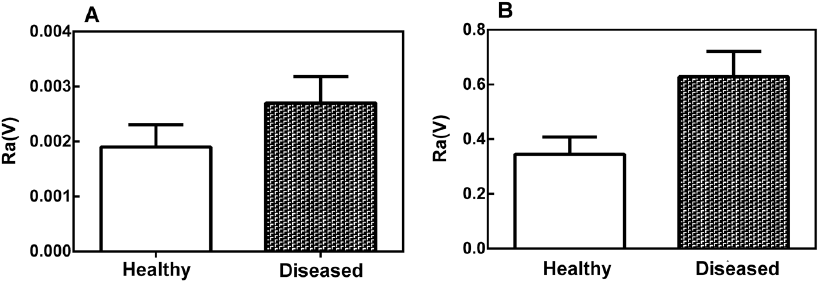
Figure 3. Structural roughness parameter Ra of the leaf midribs ( A ) and latex ( B ) of healthy and diseased papaya plants. The roughness (Ra) is the arithmetic mean of the deviations in the profile curve with respect to the midline of the basic length. The error bars represent the variations between biological replicates. The difference between the means is statistically significant (Mann–Whitney test, p < 0.05).